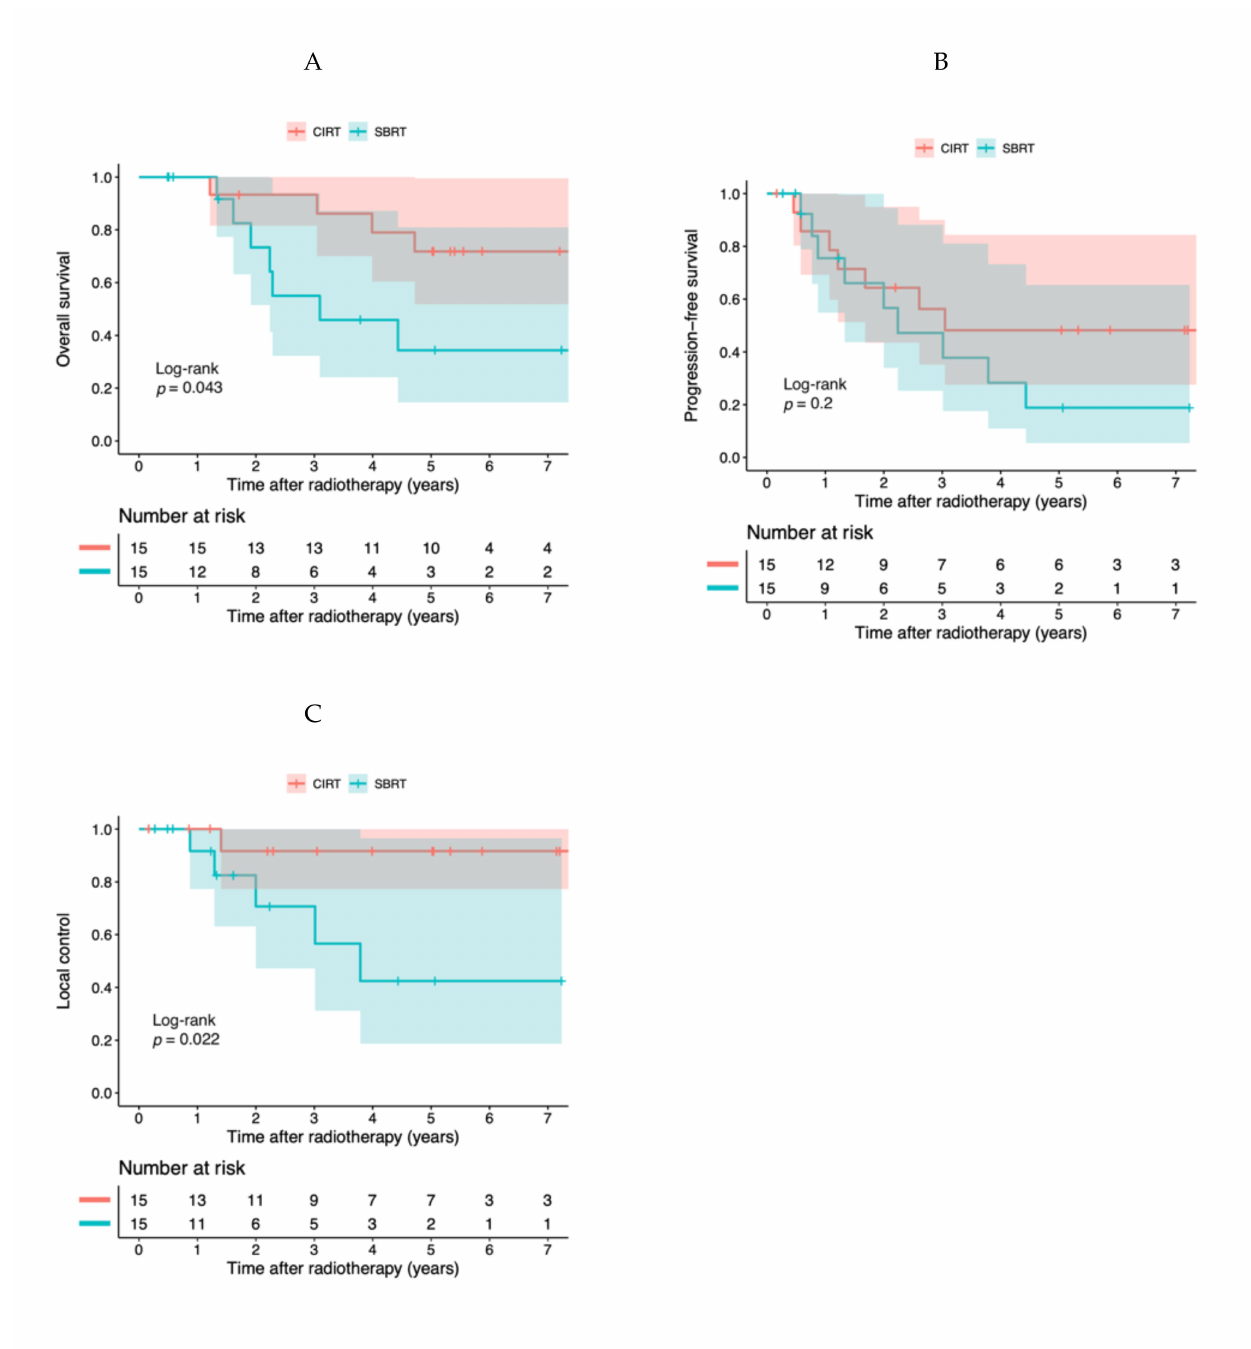
Figure 2. Kaplan–Meier curved for the matched cohort ( n = 30). ( A ) Overall survival, ( B ) progression-free survival, and ( C ) local control. Colored regions show 95% confidence